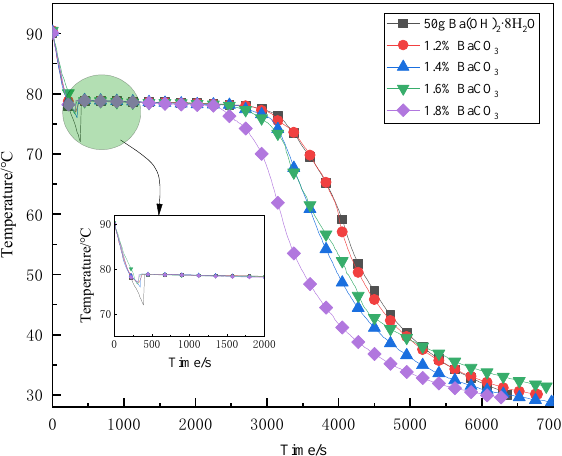
Figure 4. Exothermic curve diagram of different mass fraction BaCO 3 .